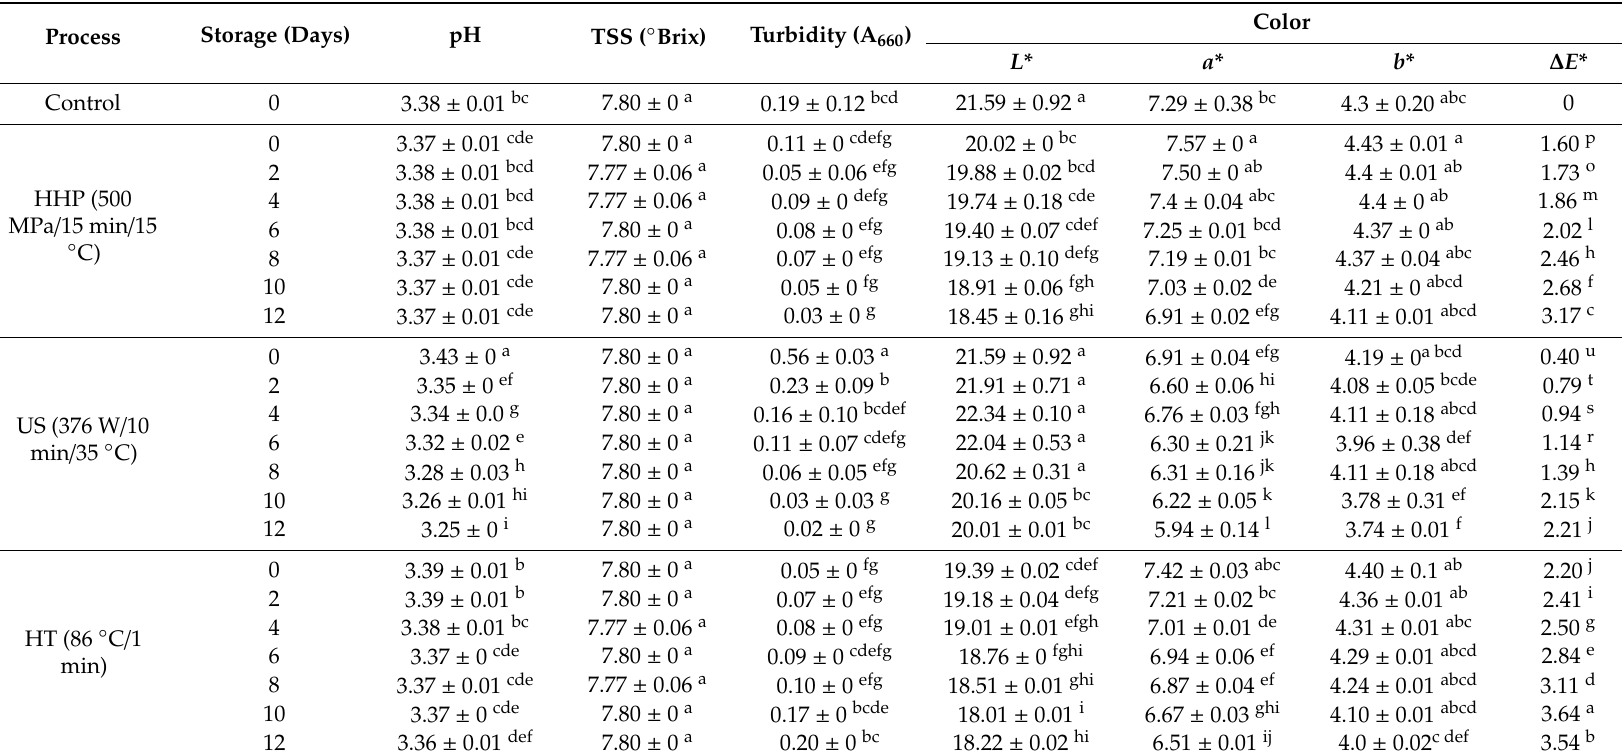
Table 2. Variations of pH, TSS, turbidity, and color parameters in juice blends treated by HHP, US, and HT after 12 days of storage at 4 ◦